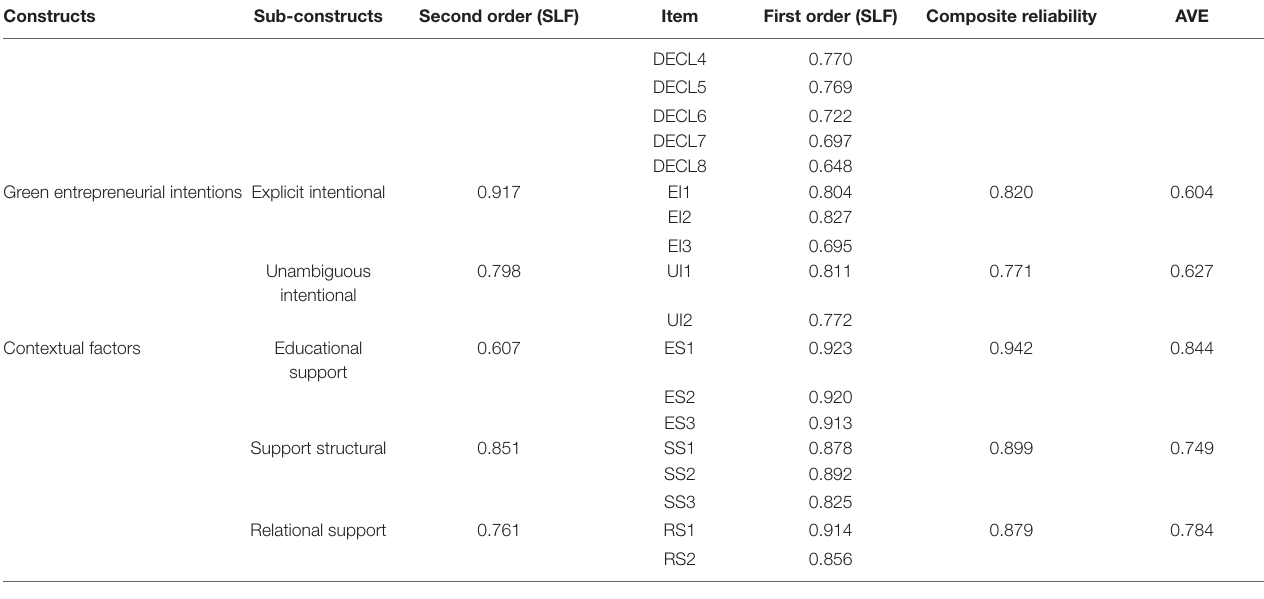
TABLE 4 | Discriminant validity—Fornell–Larcker